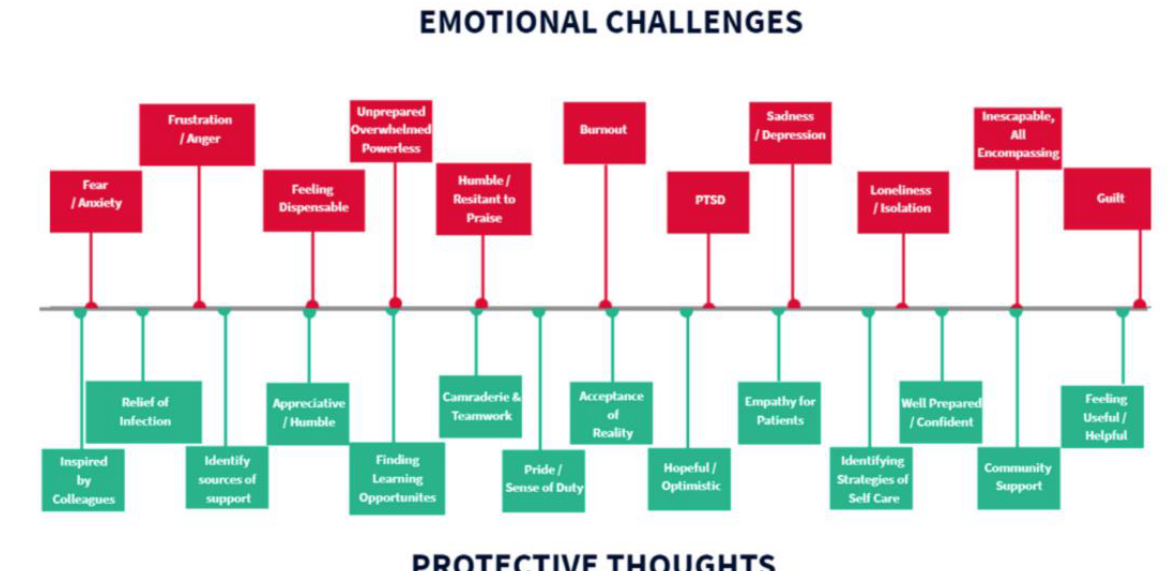
Figure 1. Diagram of a range of emotional challenges and protective thoughts of 25 emergency medicine resident physicians regarding working and training during the first wave of the COVID-19 pandemic in two urban US hospitals, 2020. COVID-19, coronavirus disease 2019; US, United States.